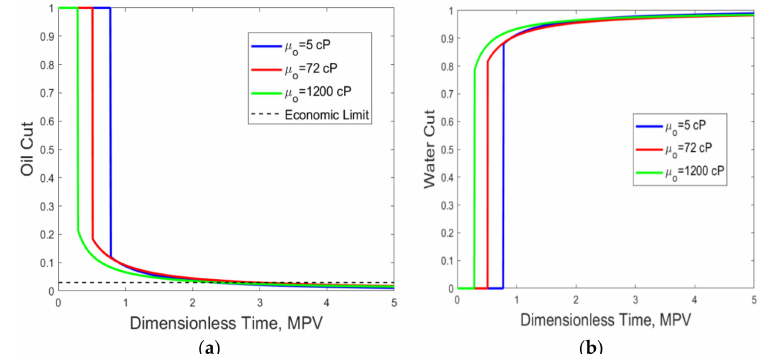
Figure 6. ( a ) Water cut history and ( b ) oil cut history during water injection up to 5.0 PV for di ff erent oil viscosity. The lines in green, red, and blue represent the cases of water flooding with high oil viscosity, moderate oil viscosity, and low oil viscosity, respectively.